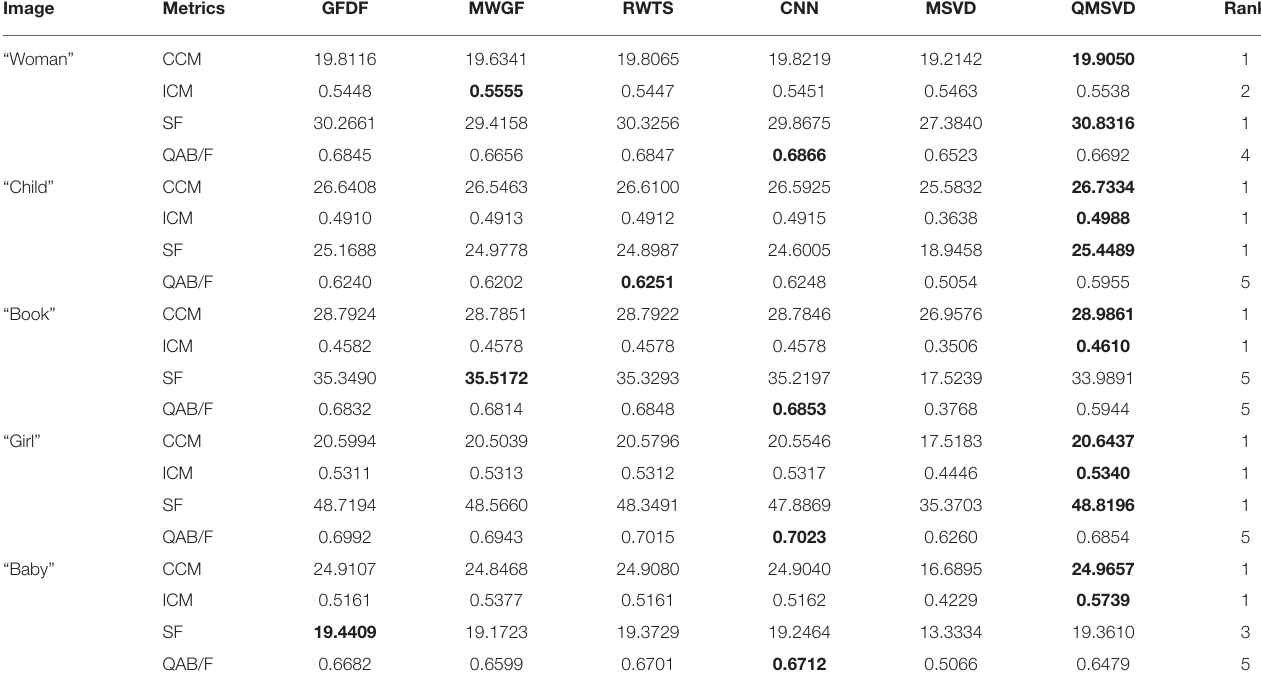
TABLE 3 | Objective evaluation values of multi-focus color images.